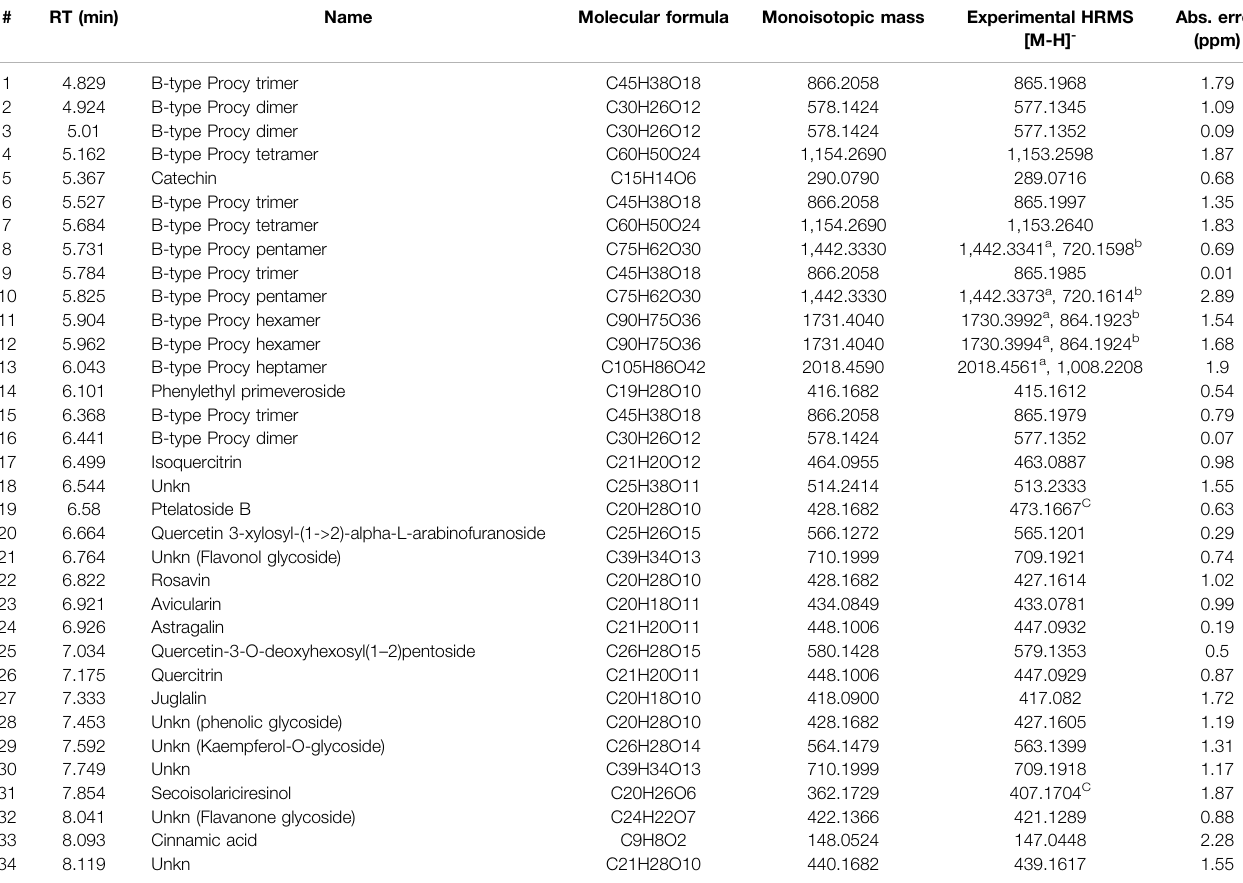
TABLE 5 | UPLC/HR-MS data for the major extract components identi fi ed in fraction B was obtained from the BCHE